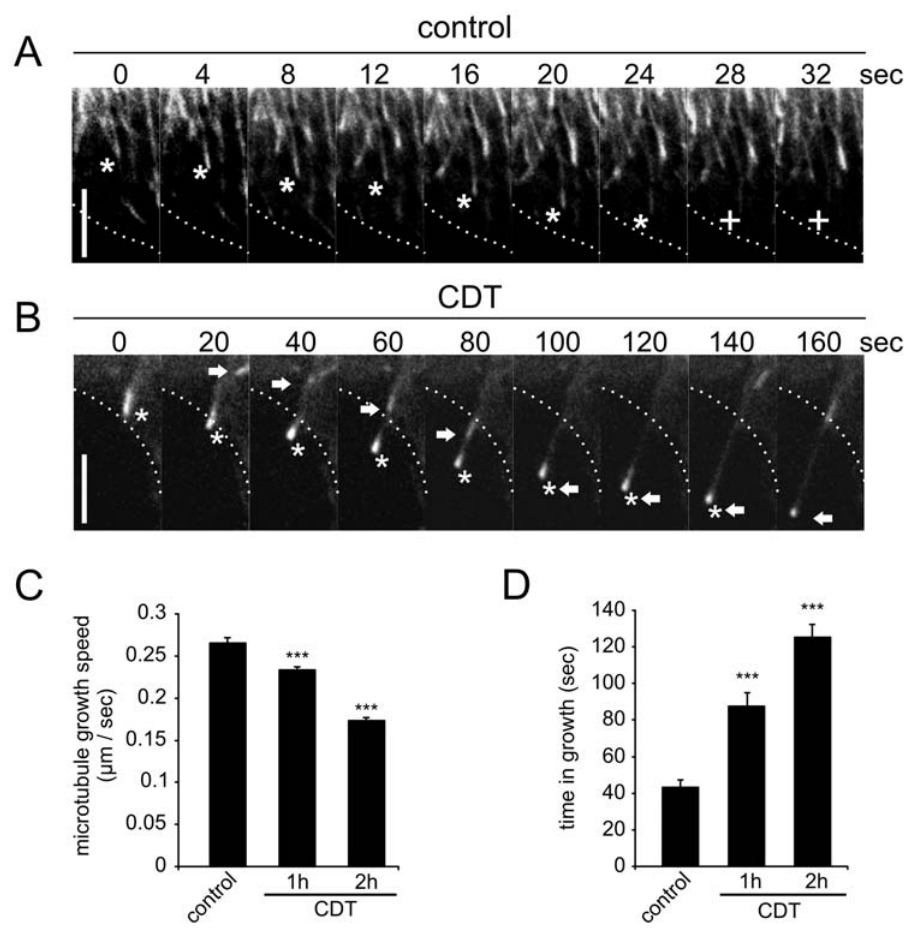
Figure 4. Influence of CDT on microtubule growth. Caco-2 cells transfected with EB3-GFP, were monitored in fluorescence time-lapse microscopy. Cells were recorded 0, 1 and 2 h after treatment with 20 ng/ml CDTa and 40 ng/ml CDTb. ( A ) Control images of EB3-GFP transfected cells show microtubules losing their EB3-comets as they approach the cell cortex. Asterisk: EB3-GFP comet approaching the cell cortex (white dotted line); cross: same comet during loss of EB3 decoration. ( B ) Images of CDT-treated (2 h) EB3-GFP transfected cells. Microtubules approaching the cell cortex do not lose EB3-association. Polymerizing microtubule forms initial protrusion and other microtubules follow the same track. Asterisk: EB3-GFP comet forming a protrusion. Arrow: a second EB3-GFP comet following the first into the protrusion. Scale bar in A and B represents 5 m m. Note different time scales in A and B . ( C ) Quantification of microtubule polymerization rate. After CDT treatment the polymerization rate of microtubules decreases. Growing microtubules (EB3-GFP comets) were tracked over 10 sec at 0 (control), 1 and 2 h after CDT-treatment. Data from 100 comets (5 experiments and 7 different cells) are given + / 2 SEM (***=p , 0.001). ( D ) Quantification of microtubule time in growth. After CDT treatment microtubules stay longer in their growth phase. The life time of 30 EB3-GFP comets from appearance to fading was measured (data are given + / 2 SEM (***=p , 0.001) from $ 5 cells and $ 4 independent experiments).